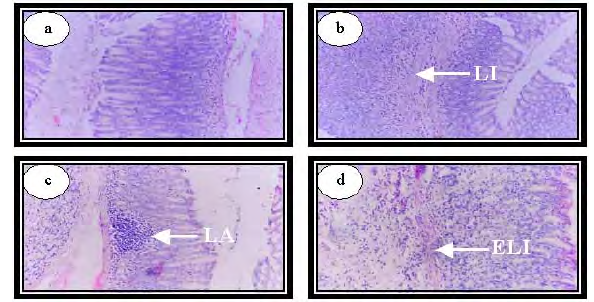
Figure 9 : Histopathology of stomach from female rats treated with saline (a) showing normal gastric mucosa; AcAaIT (b) showing leukocytic infiltration (LI) in mucosa and submucosa; AcMNPV (c) showing lymphocytic aggregation (LA) in gastric mucosa; and SlNPV (d) showing edema and leukocytic infiltration (ELI) in gastric submucosa (H&E s300).